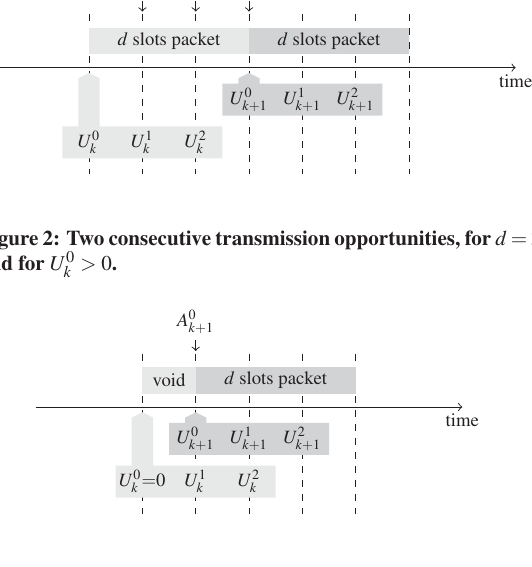
Figure 3: Two consecutive transmission opportunities, for d = 3 = 0 and for U 0 k